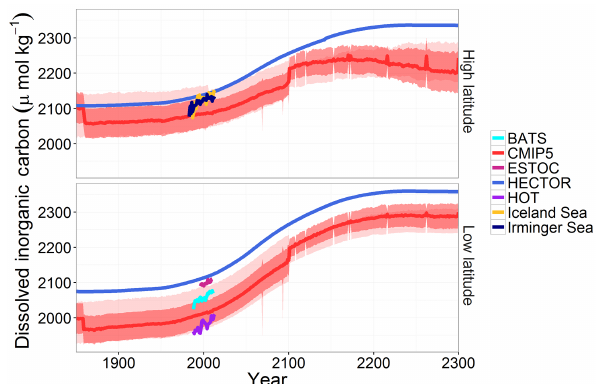
Figure 2. Dissolved inorganic carbon (DIC) for high- (top) and low-latitude (bottom) surface ocean under RCP 8.5: Hector (blue), CMIP5 median, standard deviation, and model range (red, n = 15 (1850–2100, with n = 4 starting after 1860) and n = 3; 2101–2300), as well as observations from BATS (teal), ESTOC (pink), HOT (pur- ple), Iceland Sea (yellow), and Irminger Sea (navy). Note that a doubling of CO 2 from preindustrial values occurs around 2050.